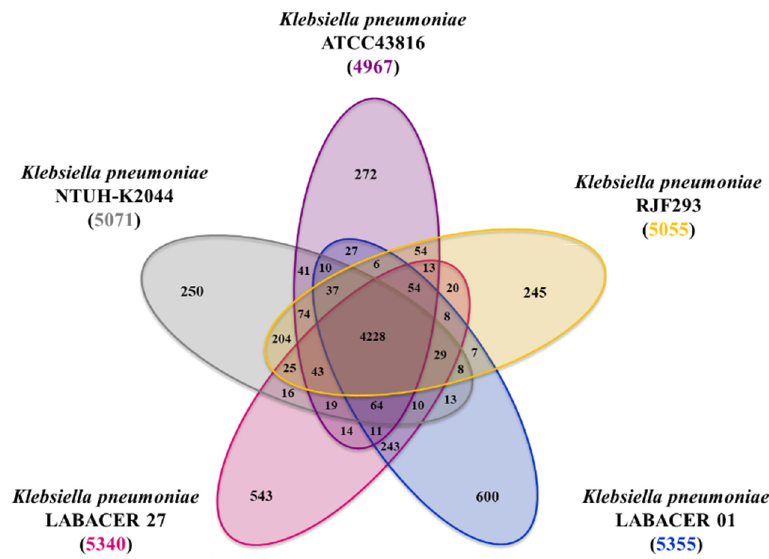
Figure 9. Venn diagram comparing shared genes and unique genes found in the sequenced genomes of Klebsiella pneumoniae strains LABACER 01, LABACER 27, NTUH-K2044, ATCC43816, and RJF293. K. pneumoniae LABACER 01 and LABACER 27 also shared genes of toxin–antitoxin systems including TabA ( tabA ), YefM ( yefM ), HigA-2 ( higA2 ), HipB ( hipB ), and HipA ( hipA ) with strains NTUH-K2044, ATCC43816, and RFJ293. Among the core virulence